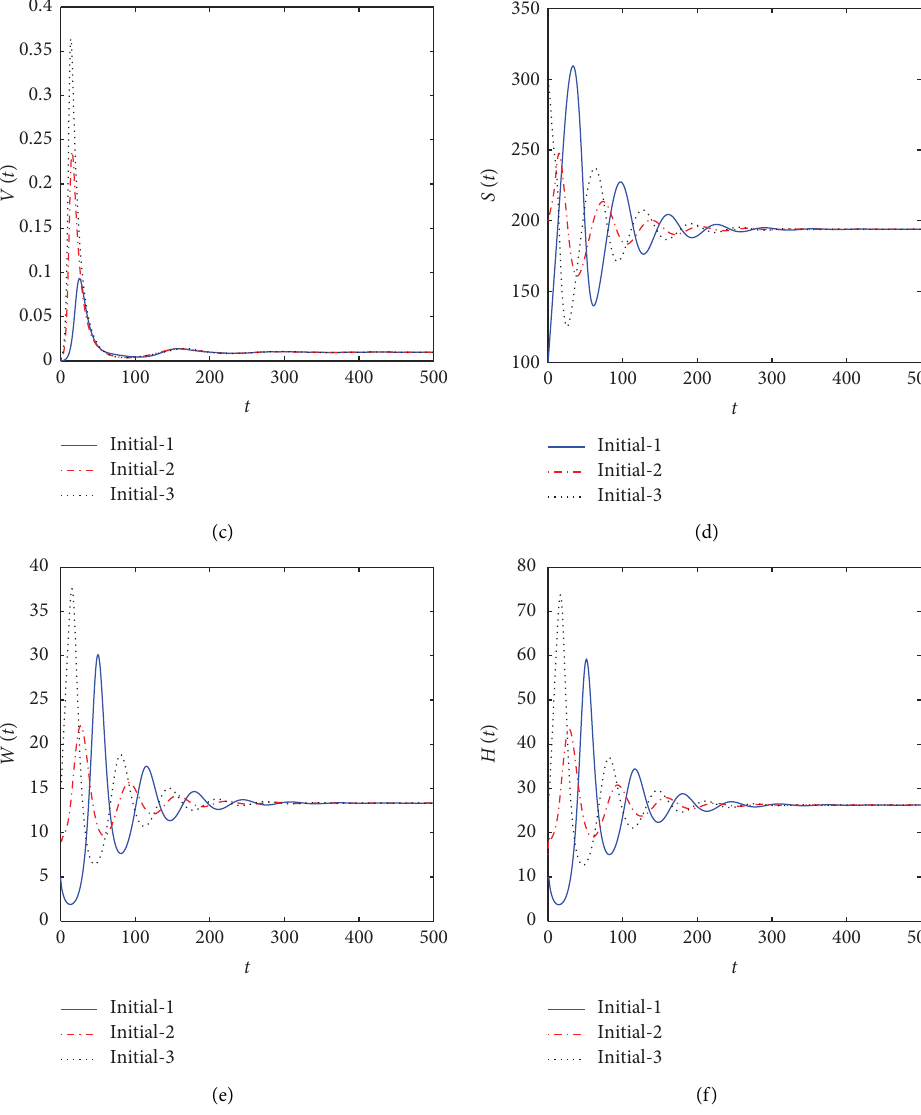
Figure 5: Model (64) numerical simulations for η � 2 . 9, υ � 0 . 02, ℘ � 0 . 1, and I � 0 . 0016 with three diferent initial conditions sets. COVID-19/AIDS coinfection equilibrium EP VH � ( 0 . 7155 , 0 . 005 , 0 . 0105 , 186 . 478 , 13 . 48 , 27 . 59 ) is G.A.S. (a) Uninfected epithelial cells. (b) Infected epithelial cells. (c) SARS-CoV-2. (d) Uninfected CD4 + T cells. (e) Infected CD4 + T cells. (f)